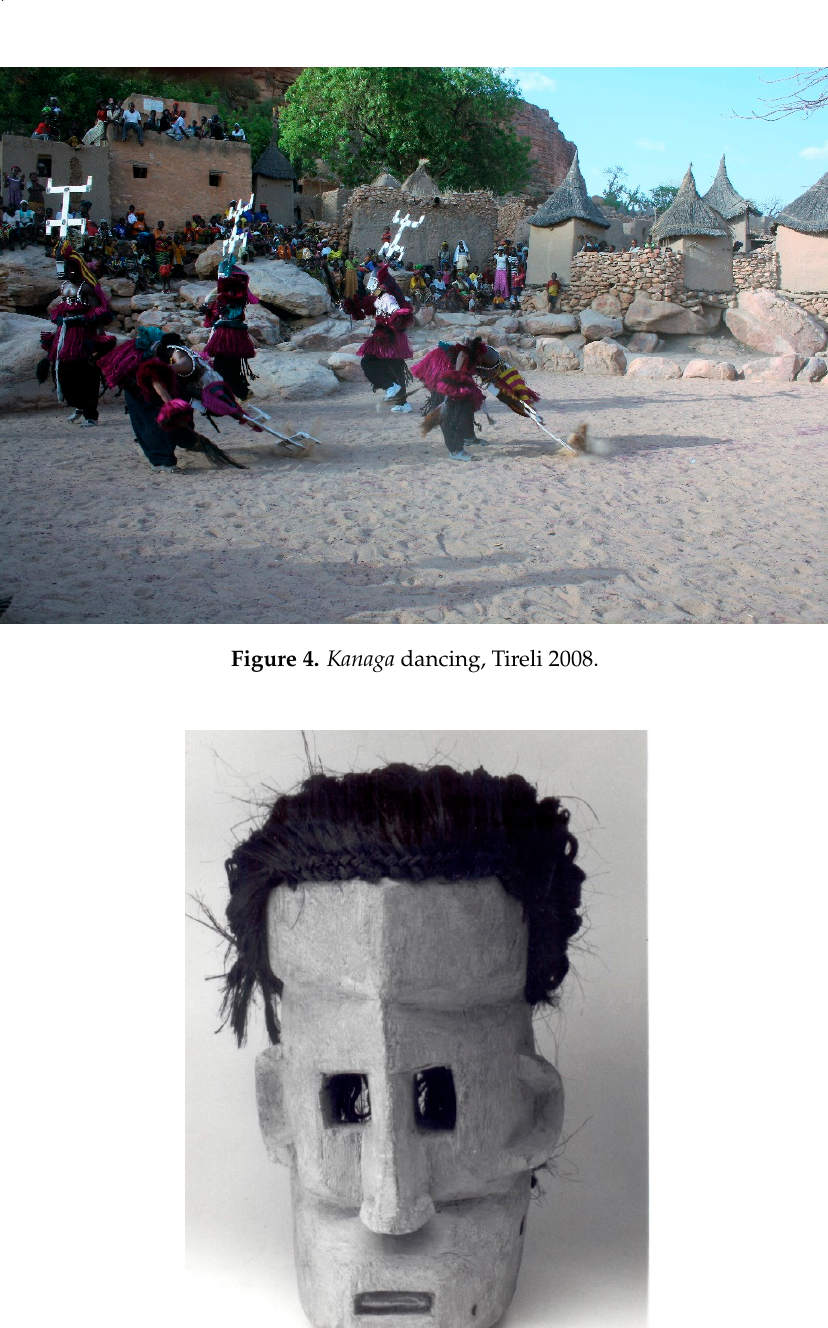
Figure 5. This is, thus, more or less the author.